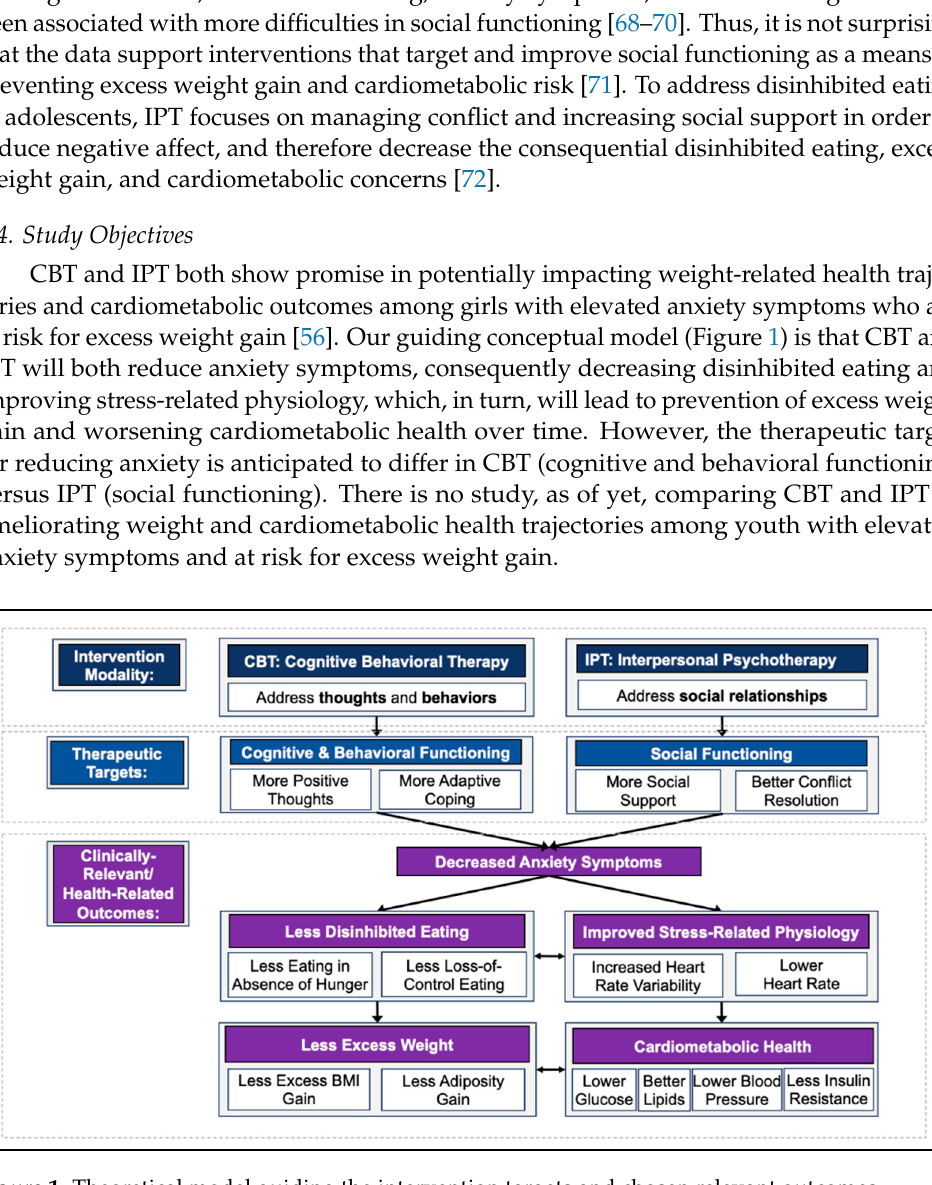
Figure 1. Theoretical model guiding the intervention targets and chosen relevant outcomes.